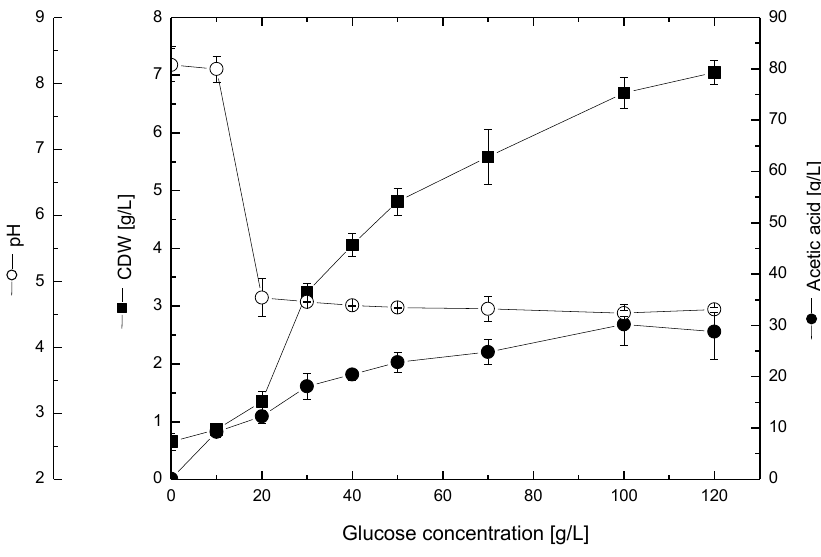
Figure 2. Effect of different glucose concentrations on cell growth, acetic acid production and pH during cultivation in shake flask